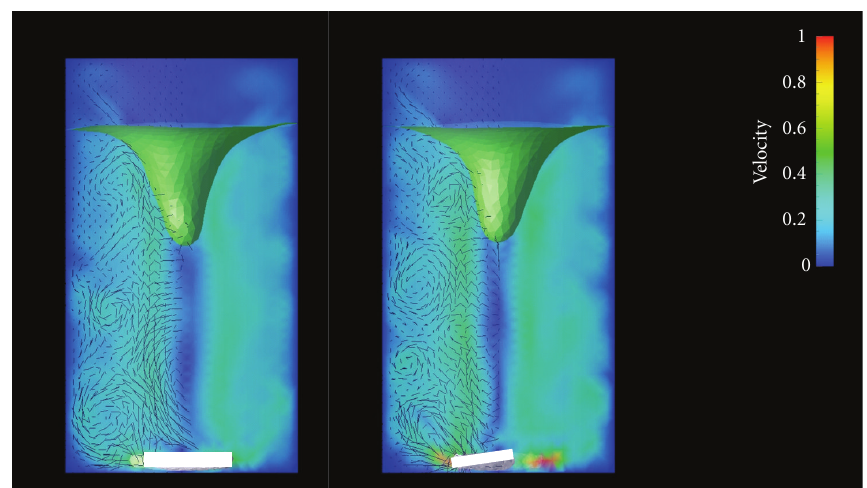
Figure 8: Vector velocity field at two di ff erent rod positions on a reactor midplane.